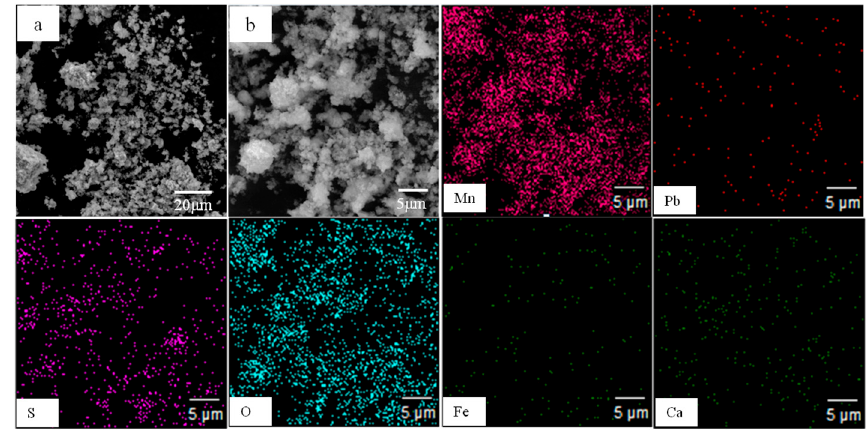
Figure 7. SEM and element distribution map of 1123 K roasted electrolytic manganese anode mud. ( a ): SEM at low magnification under conventional conditions; ( b ): a partial enlarged view of ( a